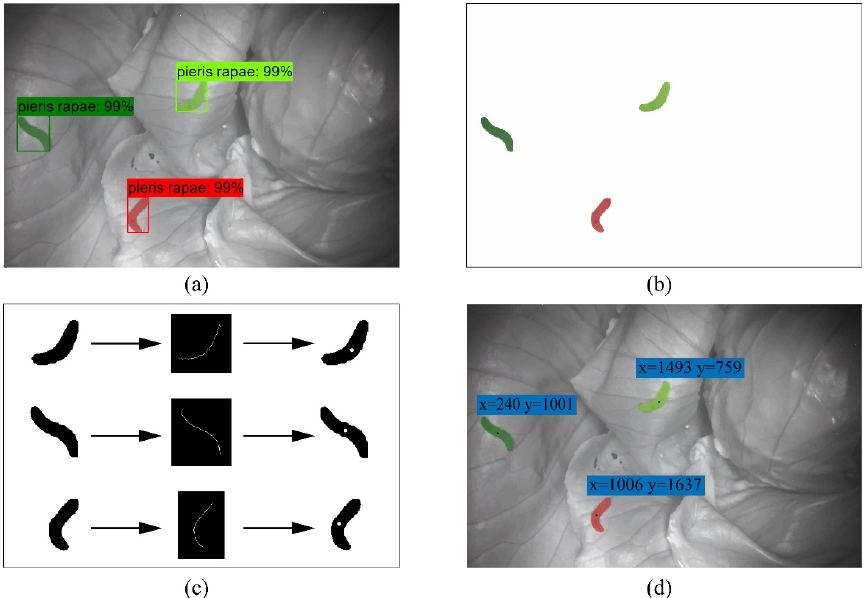
Figure 11. Visualization of the pest skeleton extraction and laser strike point location for different stages: ( a ) The identification and segmentation result of an NIR P. rapae image, ( b ) extracted segmentation mask image, ( c ) thinning treatment, and ( d ) coordinates of laser strike points.